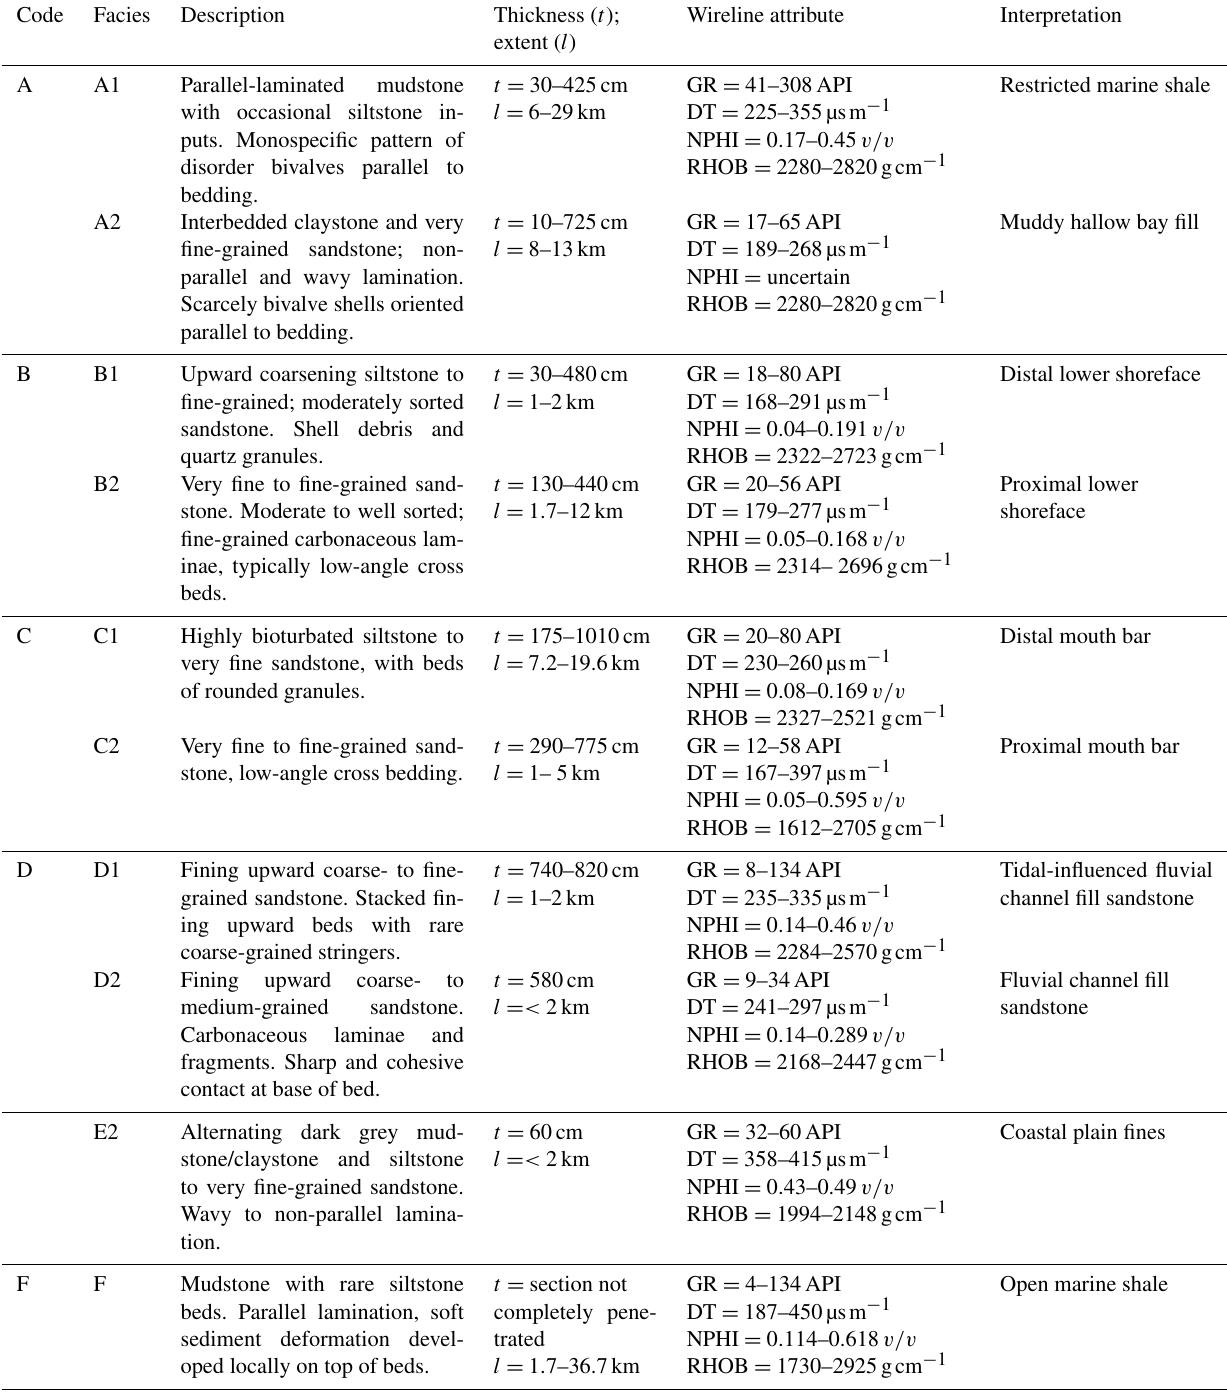
Table 1. Summarized lithofacies associations in the Hugin Formation, Volve field (after Kieft et al., 2011).